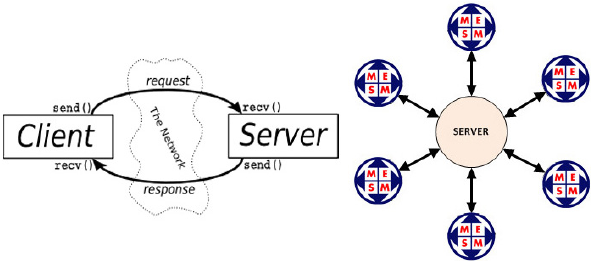
Figure 6. SBC model 1073_0 produced by the Canadian company Phidget Inc.; measurements are in inches.